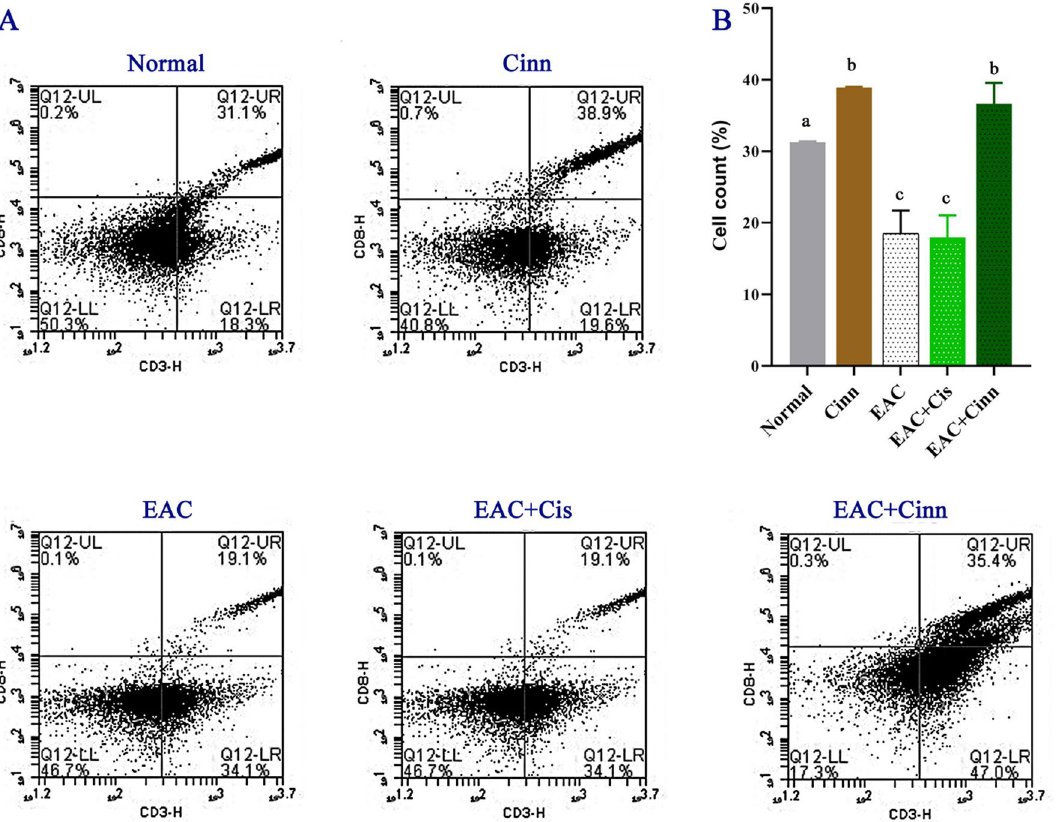
Figure 11. The effect of cinnamon essential oil (Cinn, 50 mg/kg b.wt/day, orally) on the percentage of splenic CD3 + CD8 + cells after 12 days of treatments. ( A ) Representative flow cytometric dot plot analysis (BD Accuri Ehrlich ascites carcinoma; Cis, Cisplatin (2 mg/kg b.wt,